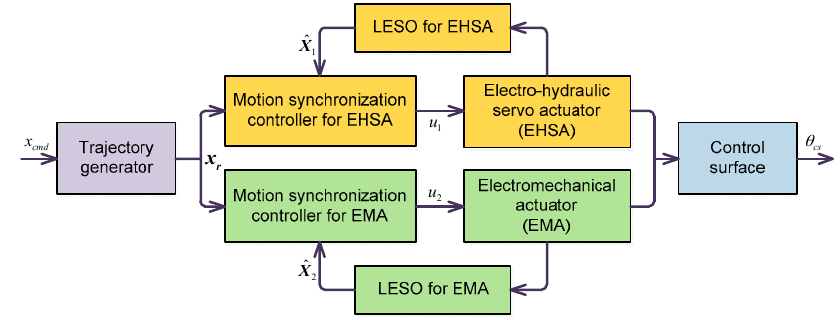
Figure 2. The overall schematic diagram of linear extended state observer (LESO)-based motion synchronization controller.